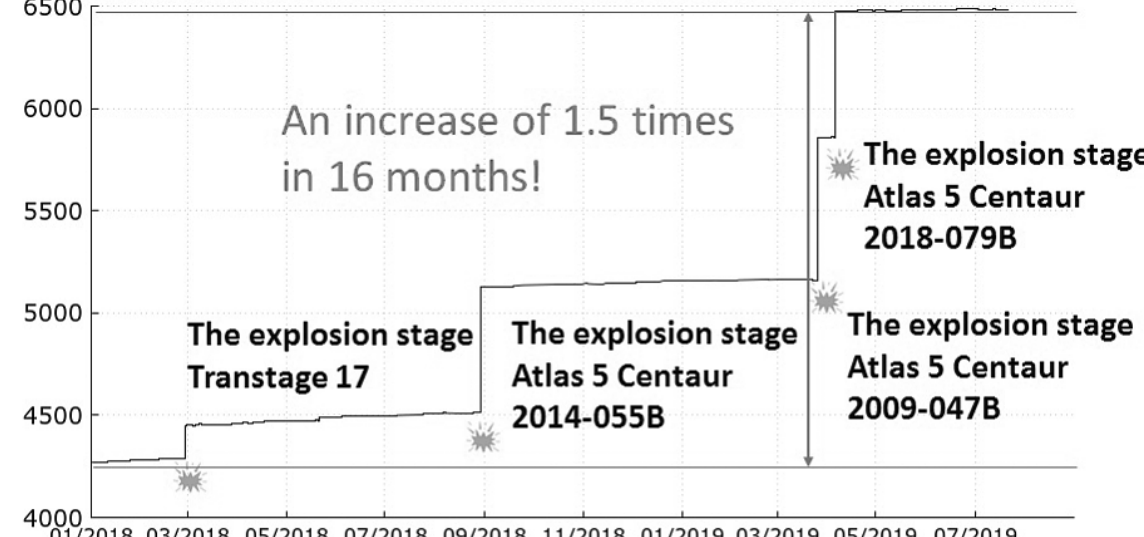
Figure 5. Changes in number of cataloged objects, identified with parent bodies. The figure shows the significant increase in the number of fragments of space debris caused by the detected destructions of rocket stages. Vertical axis - number of objects, horizontal –